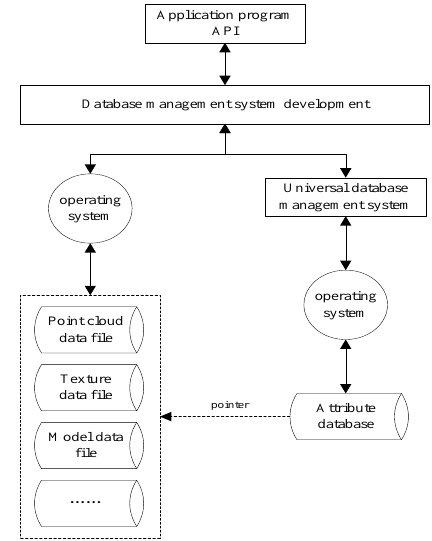
Figure 5. Data Management System Framework Diagram